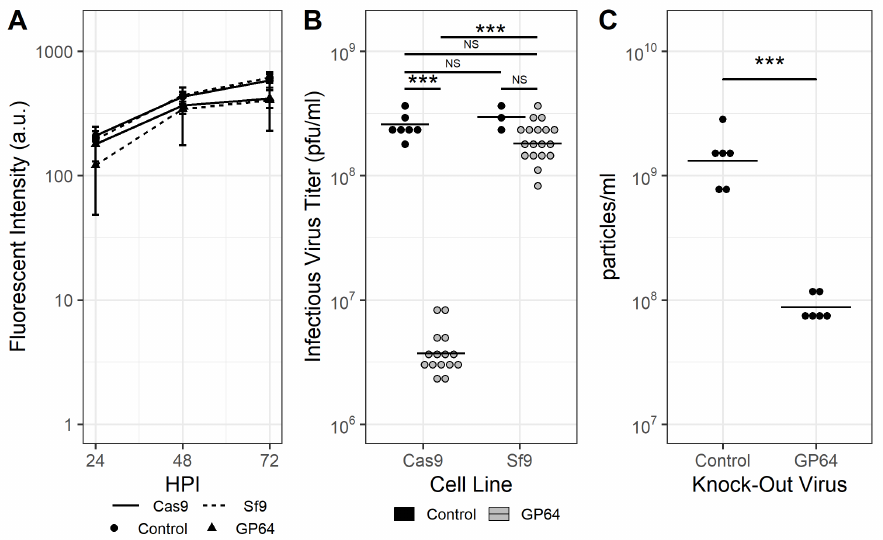
Figure 3. GP64-disrupted KOVs show reduced IVT and total particle concentration in the super- natant, but unaffected late gene expression. ( A ) Expression of the gfp gene from the viral late p6.9 promoter was similar for all rBEVs in both Sf9-Cas9 and Sf9 cells, however ( B ) IVT, and ( C ) total particle concentration was significantly reduced for control and gp64 -targeting rBEVs in Sf9-Cas9 but not parental Sf9 cells. Results in panel C. are for Sf9-Cas9 cells only. Solid line: Sf9-Cas9 cells; dashed line: Sf9 cells; untargeted control (circles) and gp64 -targeted (triangles) rBEVs. All samples were taken at 48 hpi. *** p <